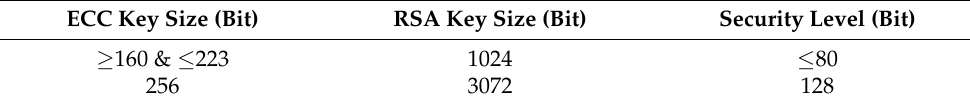
Table 1. Analysis of the security level for each ECC key size in comparison with RSA. ECC Key Size